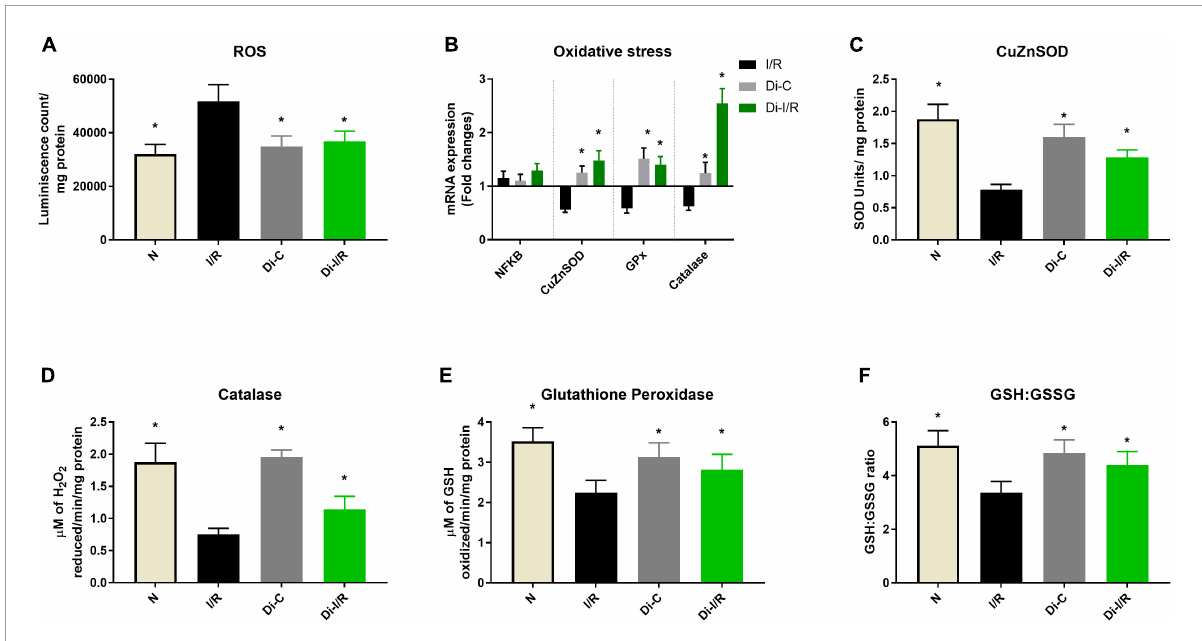
FIGURE8 mRNA expression and activity changes of oxidative stress response during DNA methylation inhibition. Panel (A) represents the ROS levels; (B) mRNA expression changes in antioxidant response genes (represented as fold changes from the normal group); Enzyme activities of antioxidant enzymes (C) superoxide dismutase (SOD); (D) catalase; (E) glutathione peroxidase; (F) GSH: GSSG ratio. * p < 0.05 vs.